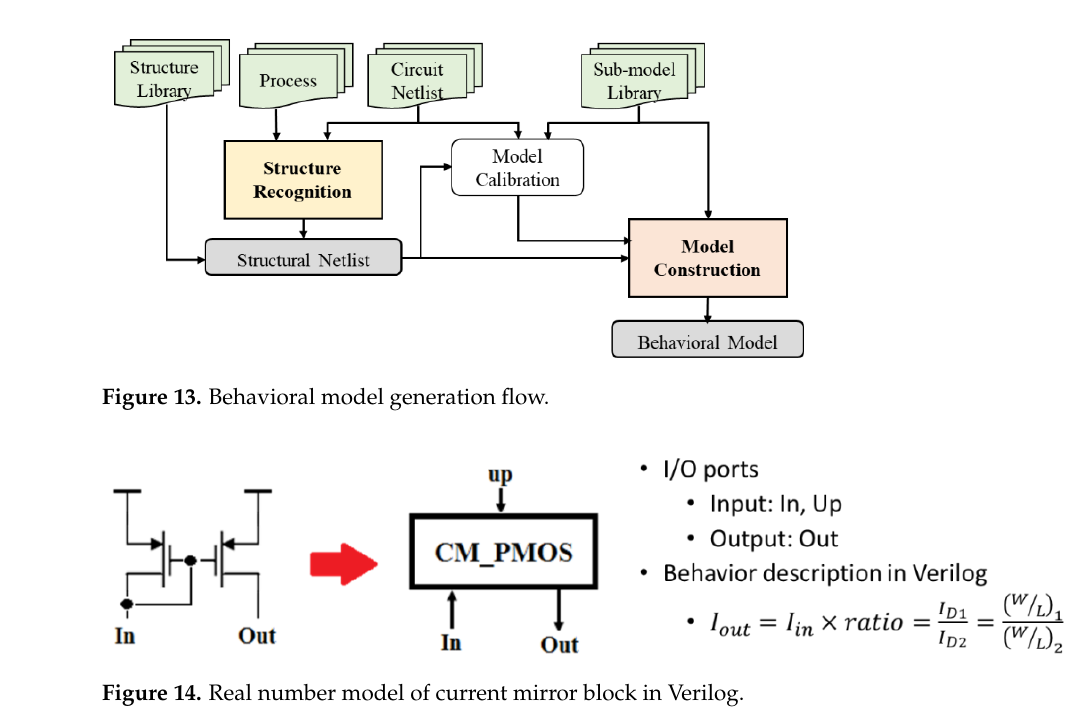
Figure 14. Real number model of current mirror block in Verilog.